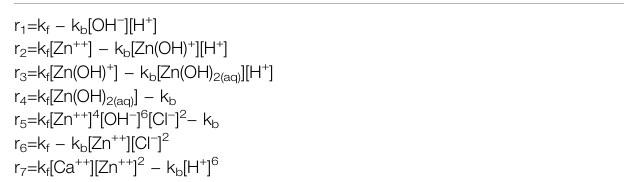
TABLE 4 | Net reaction rates.